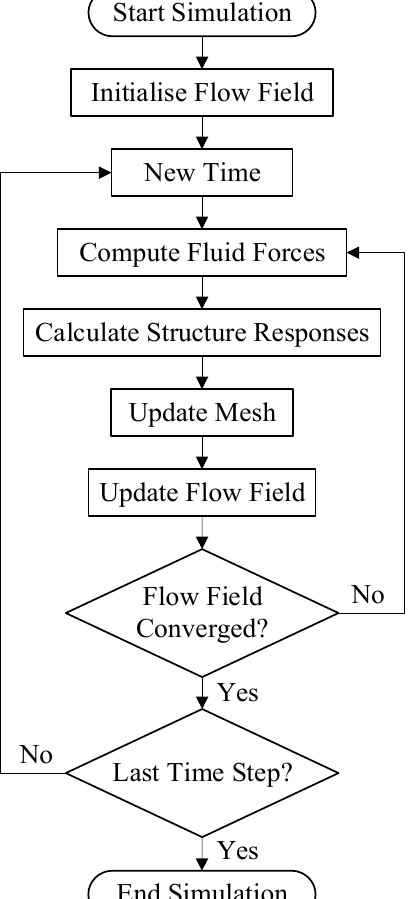
Figure 3. Flow chart of fluid-structure interaction.